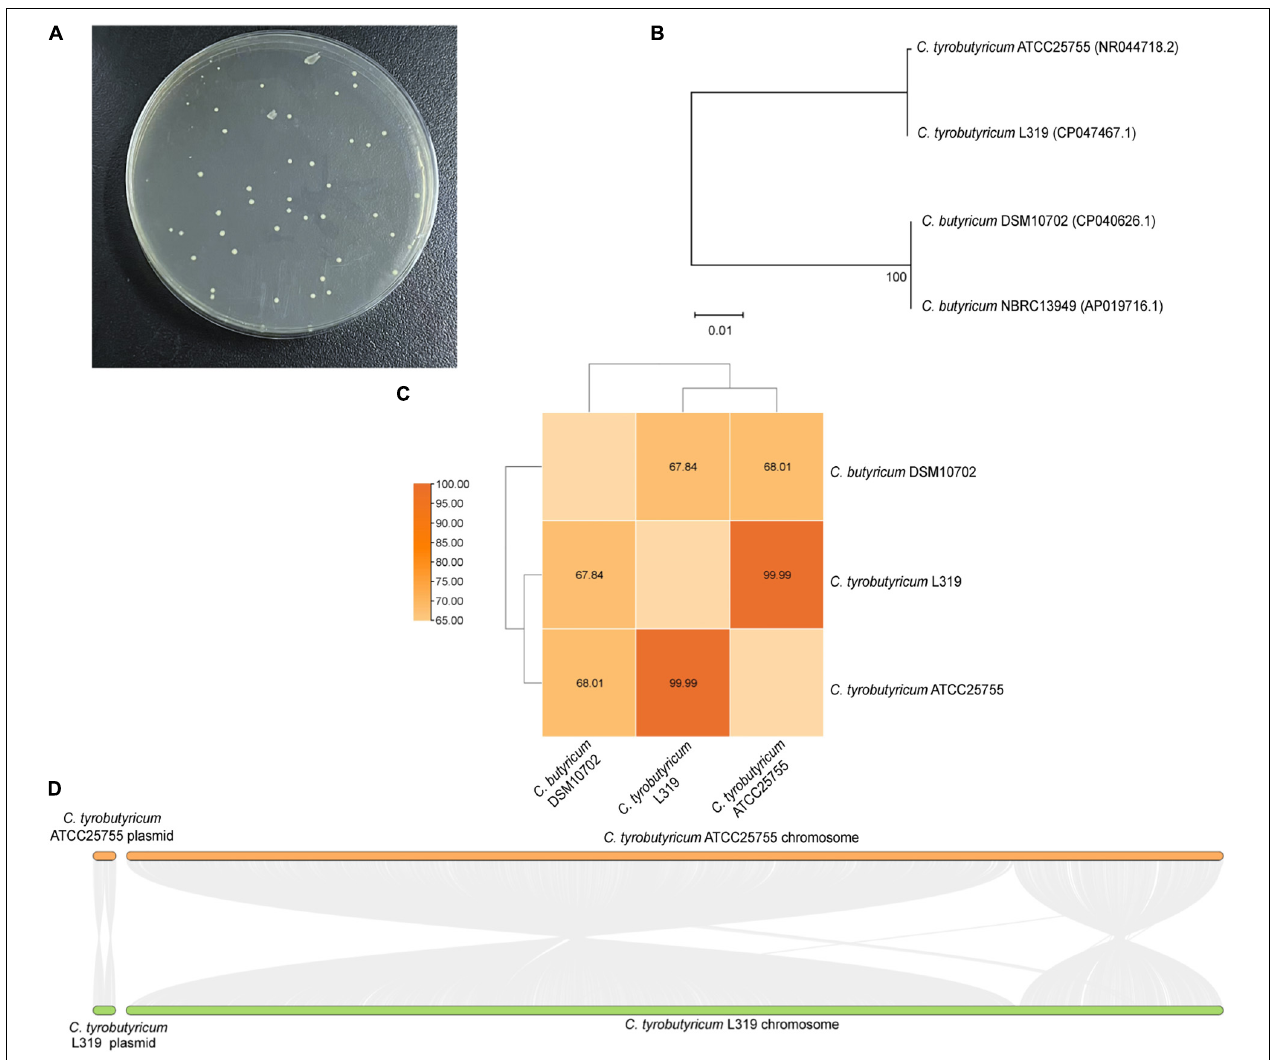
FIGURE 1 | (A) The growth of C. tyrobutyricum L319 on RCM plates. (B) The neighbor-joining phylogenetic tree based on the 16S rRNA gene sequences. (C) Heatmap of ANI between C. tyrobutyricum L319, C. tyrobutyricum ATCC 25755, and C. butyricum DSM10702. ANI values (%) are indicated. (D) Pairwise alignment between the reference strain C. tyrobutyricum ATCC 25755 and the related strain C. tyrobutyricum